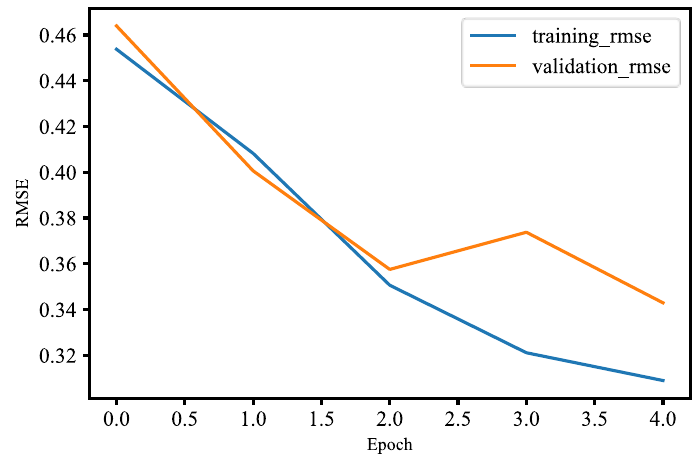
Figure 41. RMSE of human face detection.